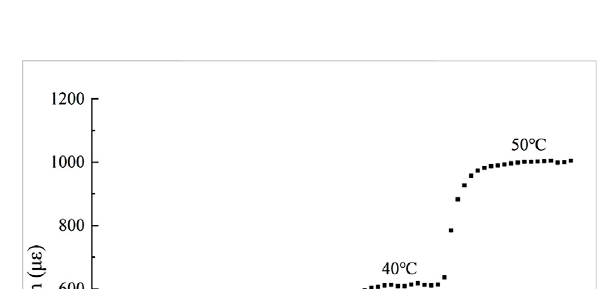
FIGURE 6 Relationship betweenthe temperature and thermal output of a thermosensor.